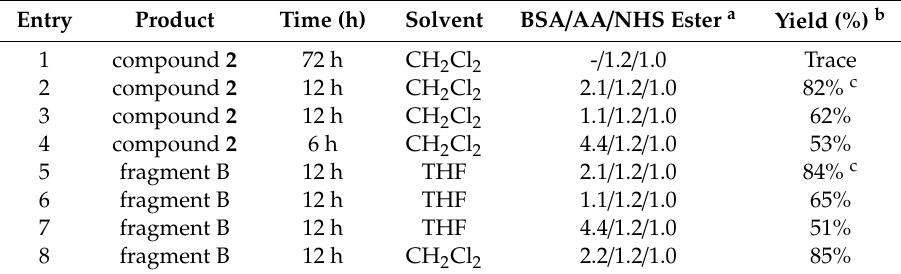
Table 1. Synthesis of protected peptides via BSA / NHS method.